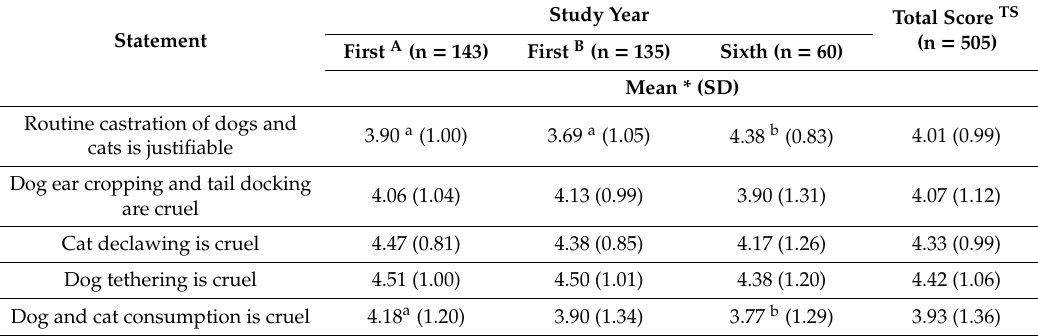
Table 3. Student opinions towards justifiability / cruelty of particular practices considering dog and cat